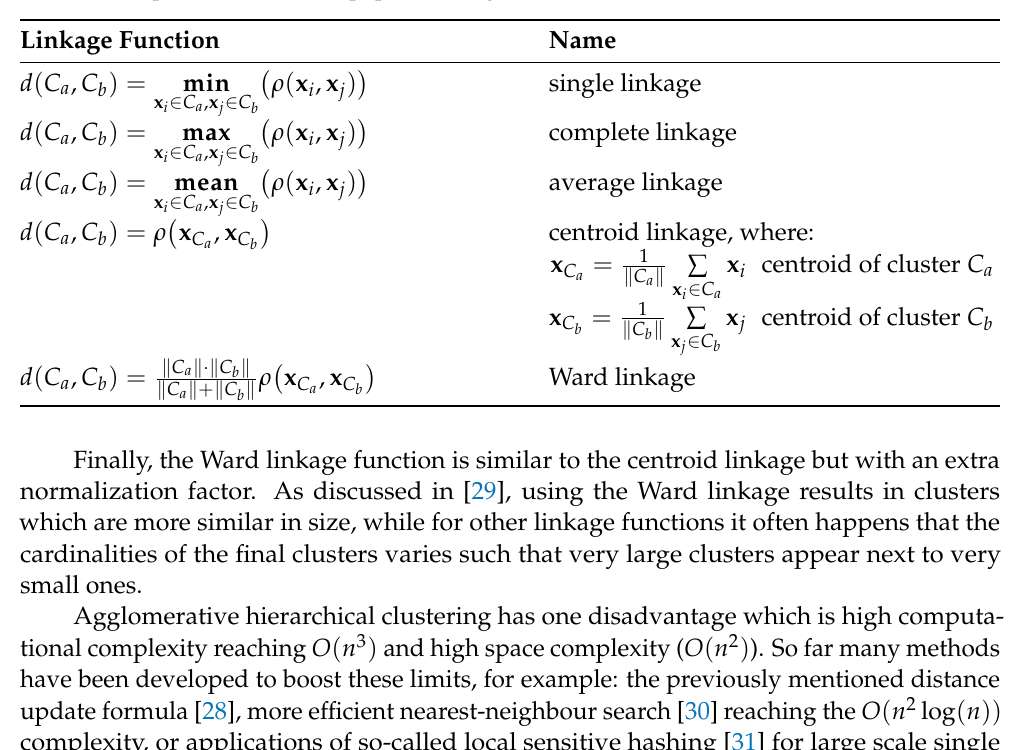
Table 1. Comparison of the most popular linkage